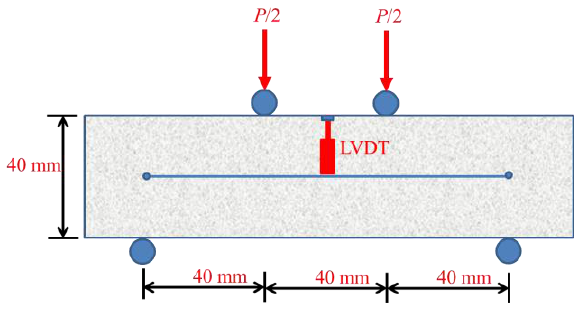
Figure 2. Experimental setup of four-point flexural loading.